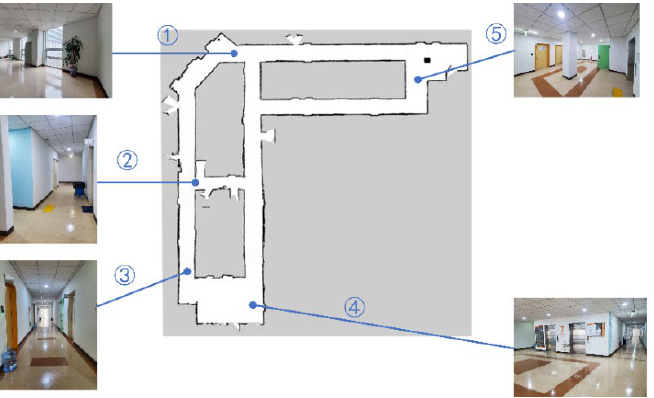
Figure 12. Occupation map generated by Owlbot SLAM . Owlbot leaves from ① , goes through ② , ③ , ④ , and ⑤ , and finally returns to ① .